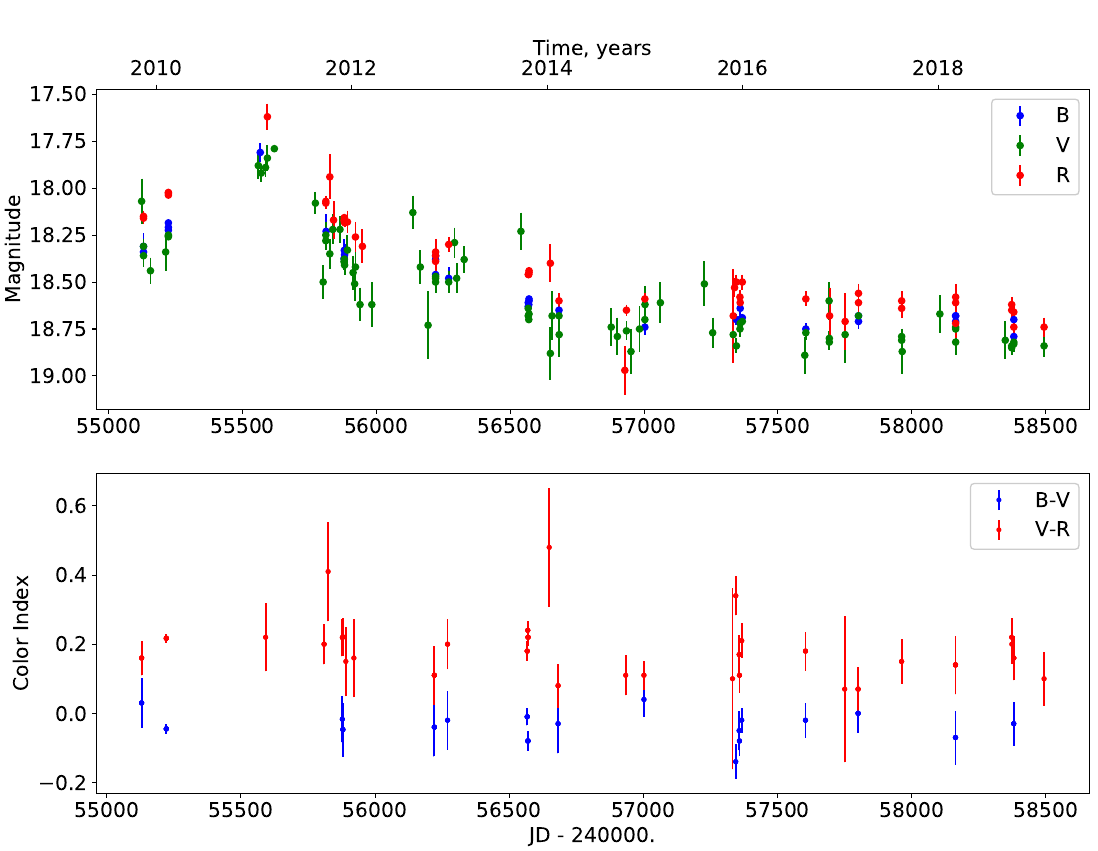
Figure 3. ( top ) Light curve of GR290 in the B, V and R filters obtained by us between 2010 and 2019 and partially published in Polcaro et al. [10]. ( bottom ) ( B − V ) and ( V − R ) colour indices for the same time interval.